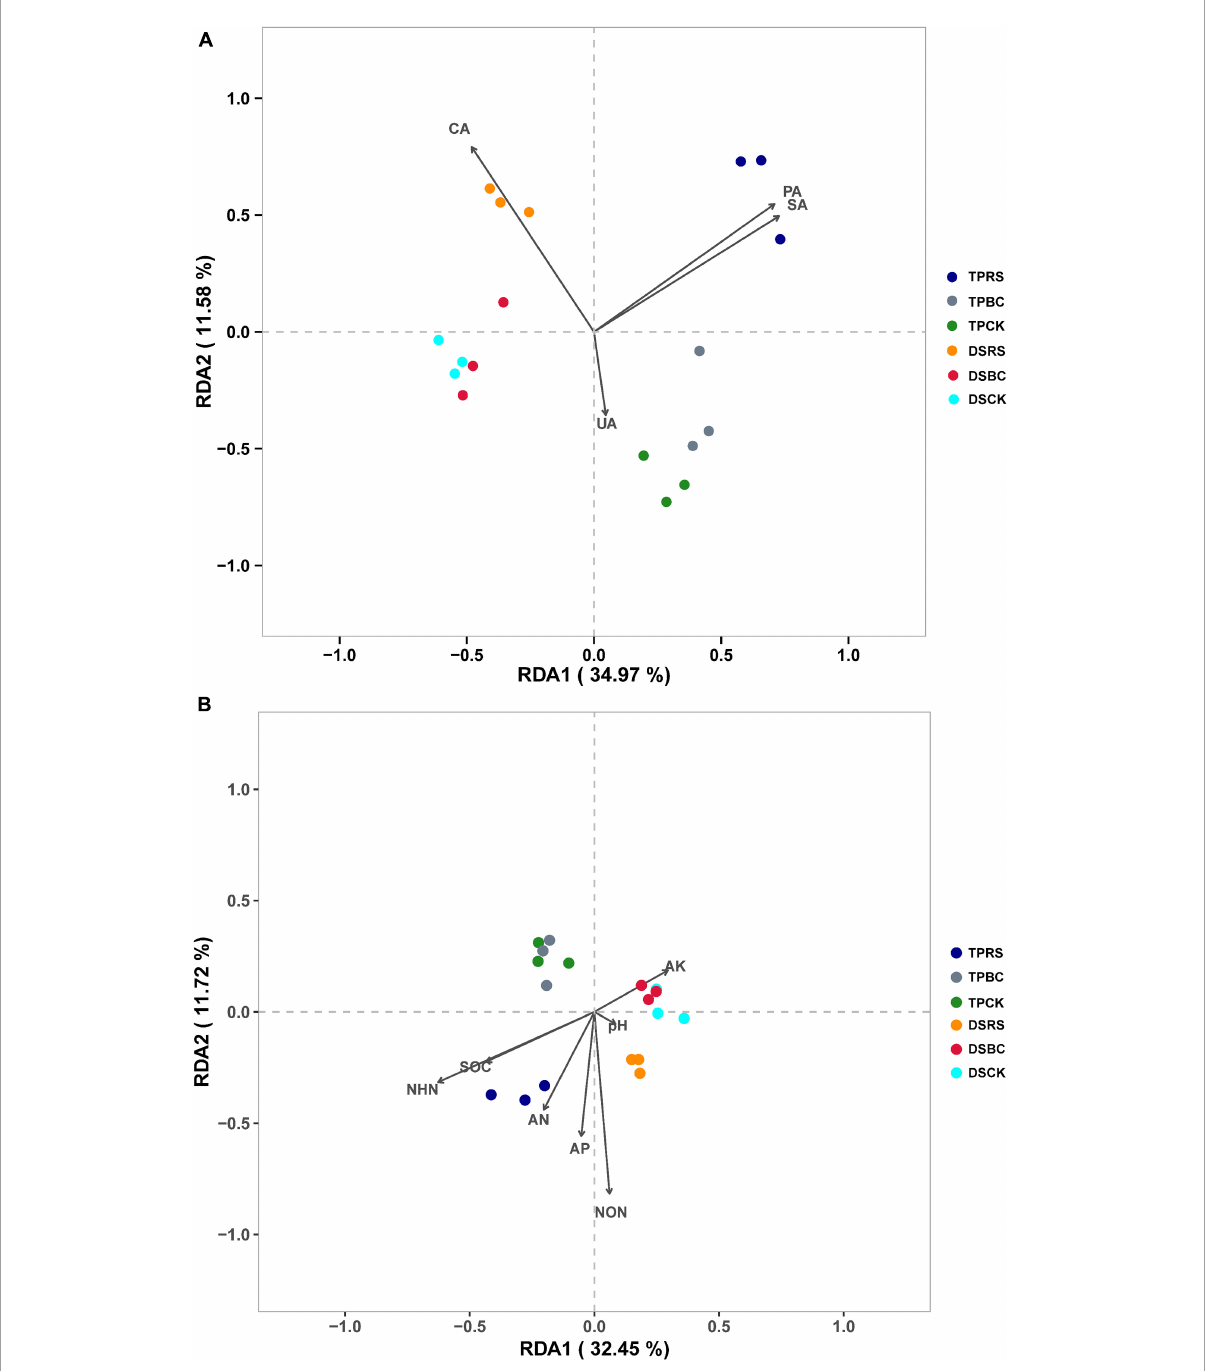
FIGURE5 (A,B) Redundancy analysis of rhizosphere soil bacterial genera and soil enzyme activity and physicochemical characteristics.